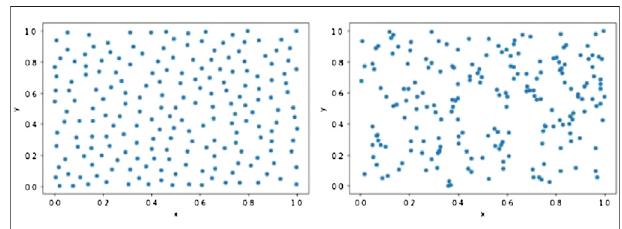
FIGURE 2 | Blue noise sampling and stochastic sampling in the two- dimensional